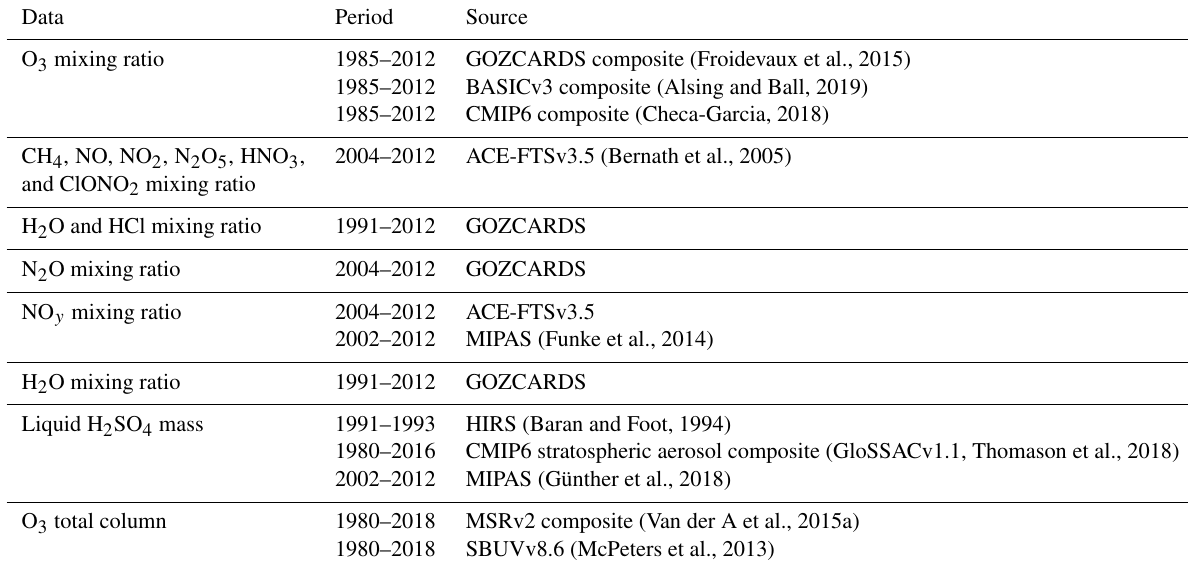
Table 1. Data used in this study for chemistry